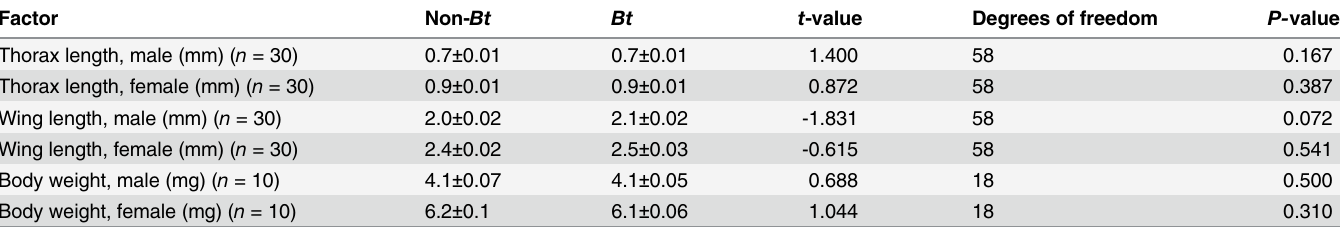
Data are means ± standard errors. a P -values are from Student ’ s t -tests.